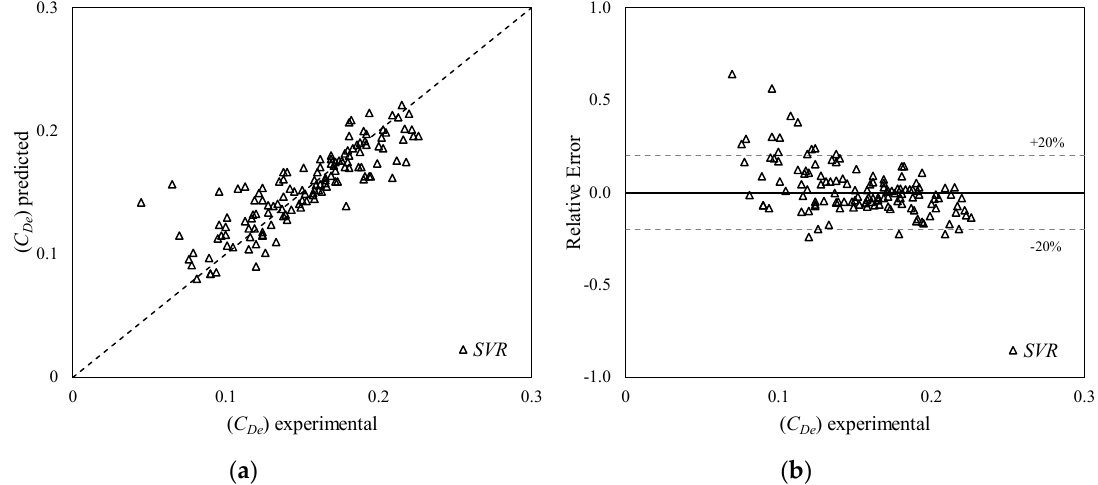
Figure 12. Model 2, SVR algorithm, ( a ) predicted versus experimental results, and ( b ) relative error versus experimental results.